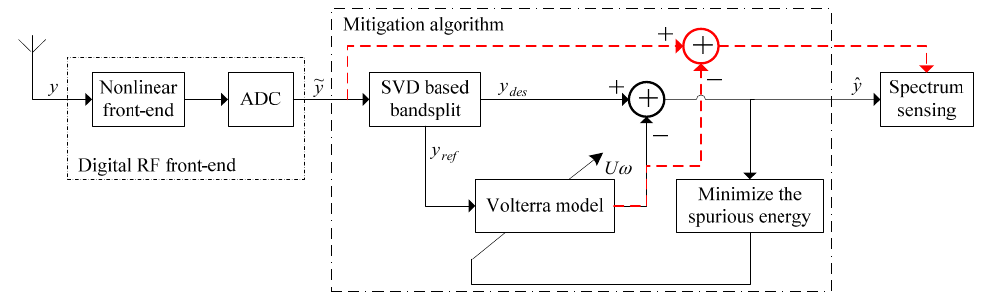
Figure 5. Proposed mitigation structure for RF front-end nonlinearity.